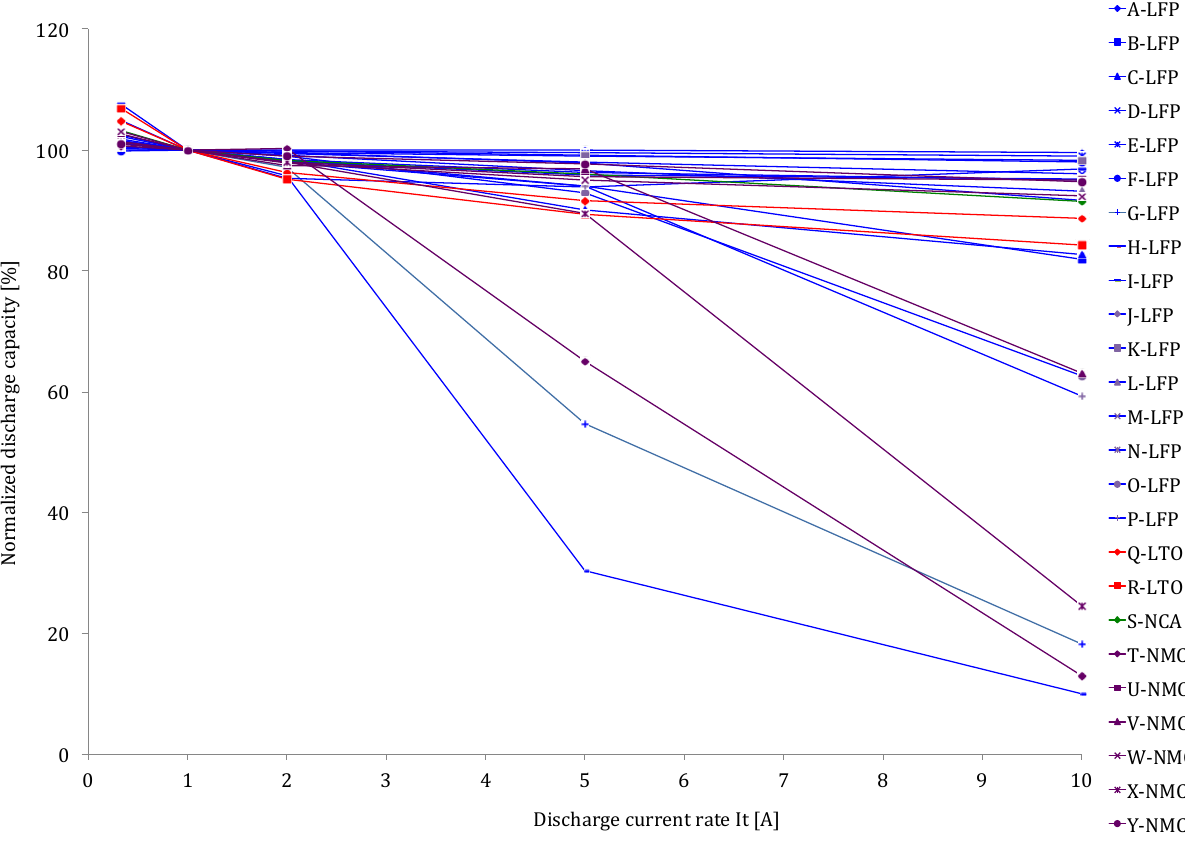
Figure 12. Discharge capabilities at different current rates.